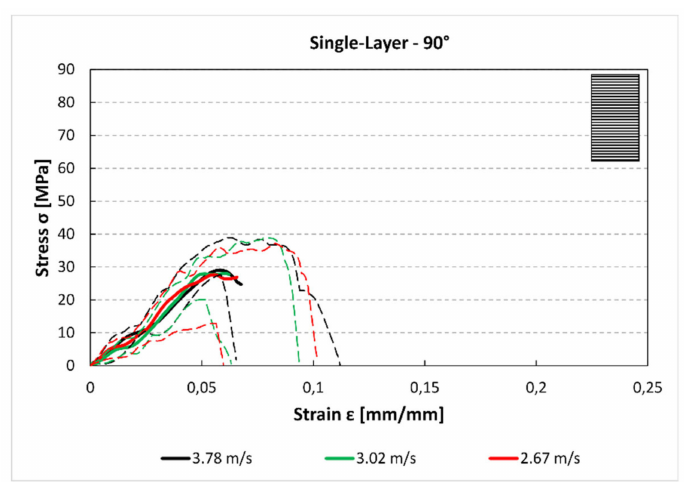
Figure 7. Single-layer stress–strain curve for 90 ◦ specimen and for each impact speed.